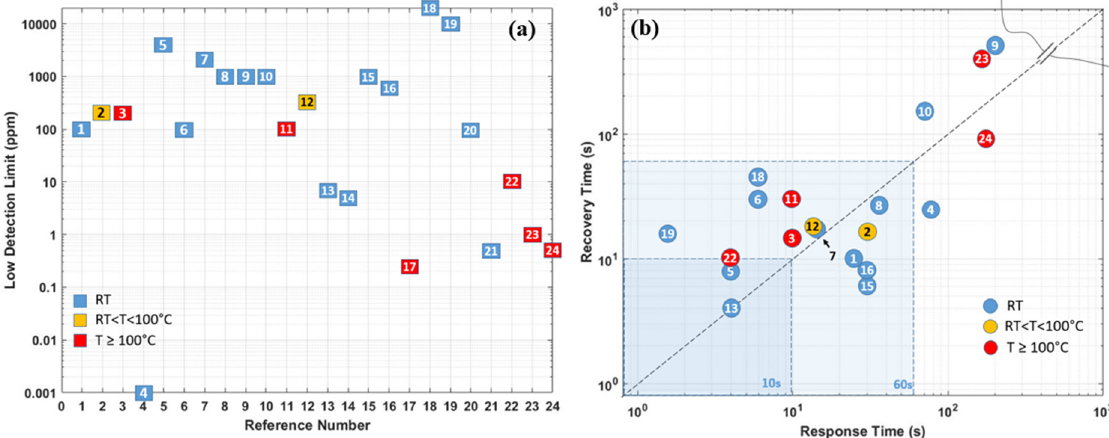
Figure 18. Regarding Table 1, schematic illustrations of the comparison of the reported Pd-based hydrogen gas sensors in literature: ( a ) low detection limits. The x-axis “Reference Number” represents the 1st column“Ref. Nr.“ in Table 1. ( b ) Response time/recovery time under experimental conditions as reported in the literature.